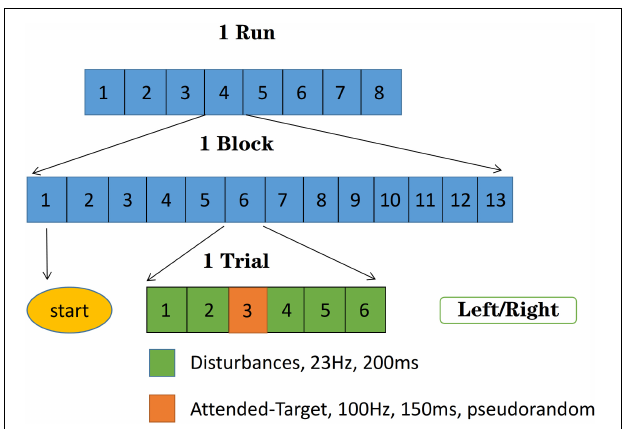
FIGURE 3 | Experimental procedure: The target stimuli were 100 Hz with the duration of 150 ms, the disturbances were 23 Hz with the duration of 200 ms. Each run consisted of eight blocks with only one target site (left or right) stimulated in one block, and each block contained 13 trials. Each trial contained six stimuli, in which the only one target stimulus was selected pseudorandomly, and others were disturbances. The first trial in each block was all six disturbance stimuli to mark the start of the block.